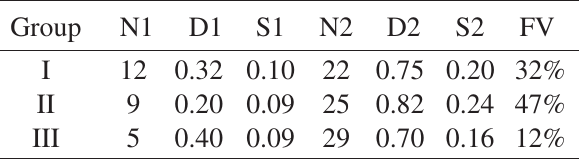
Table I. Warm events classification results. N1, D1, S1: number of elements, average distance and standard deviation of the latter within a given group. N2, D2, S2: same as above for events outside a given group. FV: fractional contribution to the variance of the Niño3 Index due to all warm events by those in a given group.